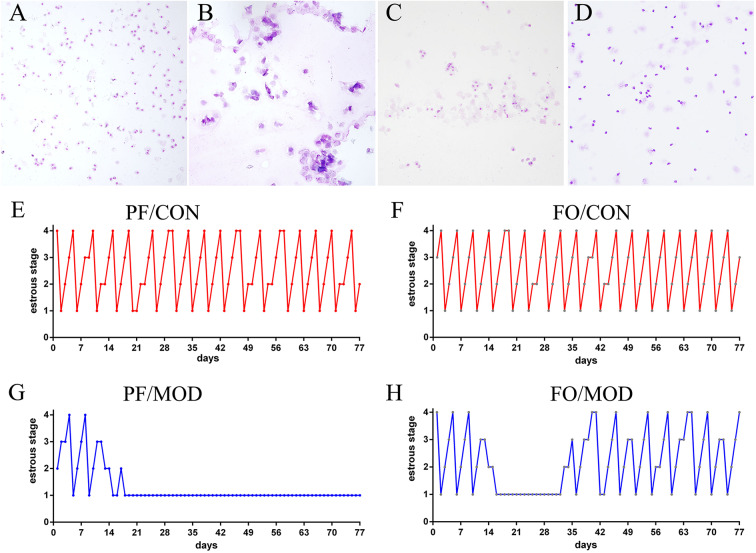
Estrous cycle changes in representative rats from diverse groups. (A) Vaginal smears of proestrus stage. (B) Vaginal smears of estrus stage. (C) Vaginal smears of metestrus stage. (D) Vaginal smears of diestrus stage. (E–H) Representative estrous cycles of diverse groups: 1, diestrus stage; 2, proestrus stage; 3, estrus stage; 4, metestrus stage. Original magnification (×100).